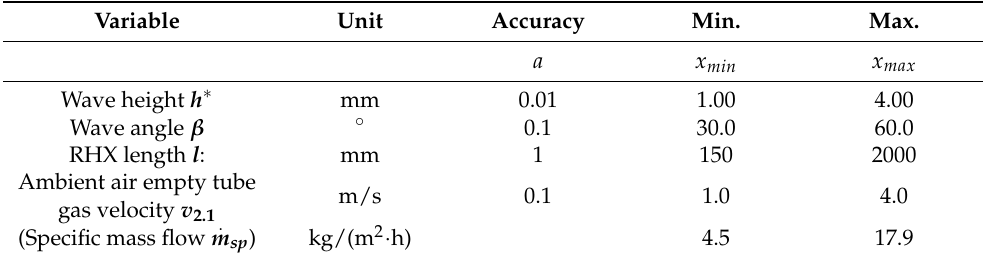
Table 2. Variables, accuracy, and ranges (including endpoints) for the optimization. Variable